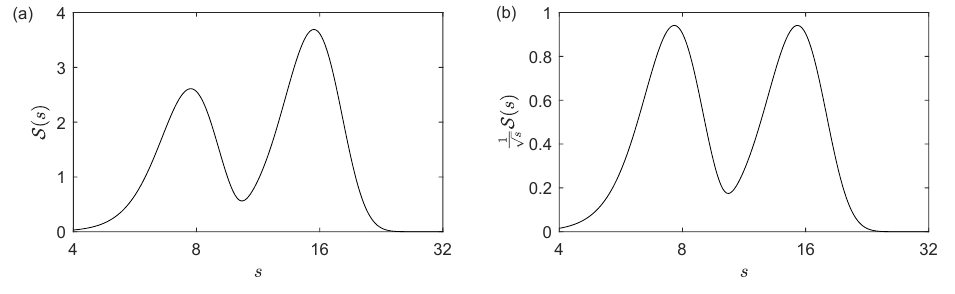
(cid:16) (cid:17) (cid:16) (cid:17) 2 π 2 π + sin t t with t ∈ [ 0,1000 ] , 8 16 . s